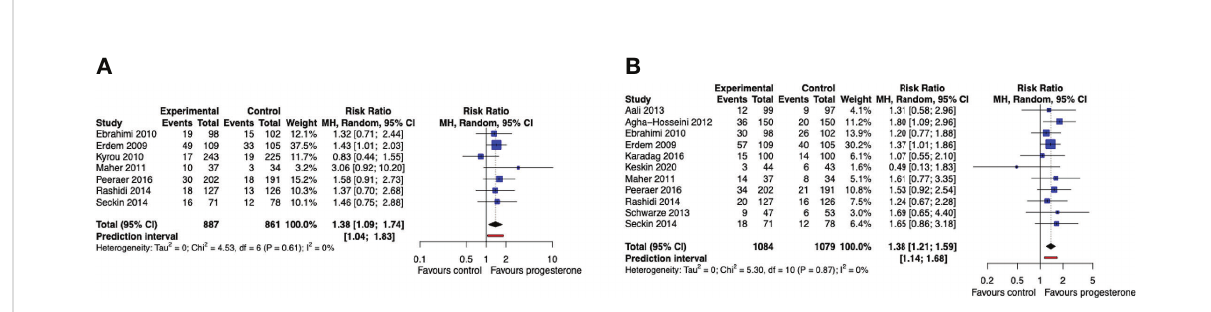
FIGURE 4 Cumulative live birth and clinical pregnancy rate. Comparison: progesterone luteal phase support versus placebo or no intervention. (A) Forest plot of live birth. (B) Forest plot of clinical pregnancy. MH, Mantel-Haenszel; CI, con fi dence